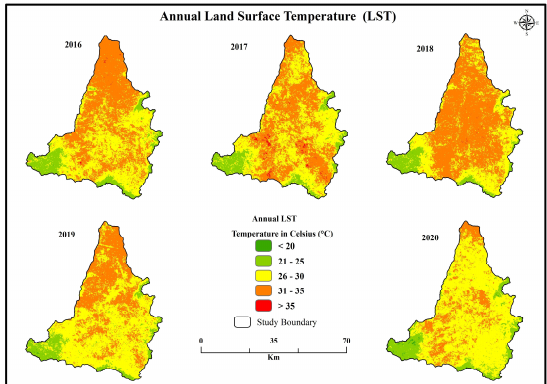
Figure 4: Annual Land Surface Temperature of 2016 to 2020